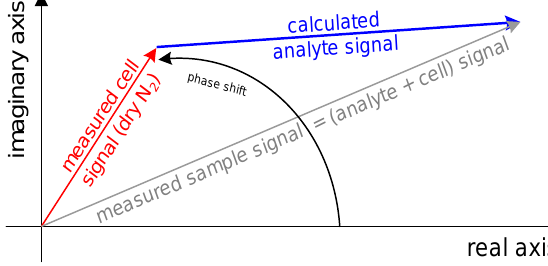
Figure 2. Complex background subtraction strategy at one, arbitrary wavenumber illustrated with vectors in the complex plain. The measured signal with analyte in the cell (grey) contains the signal from both analyte and cell. The measured signal from dry N (red) only contains the signal from the cell. The desired pure analyte signal (blue) results from the complex background subtraction of the measured cell signal from the measured sample